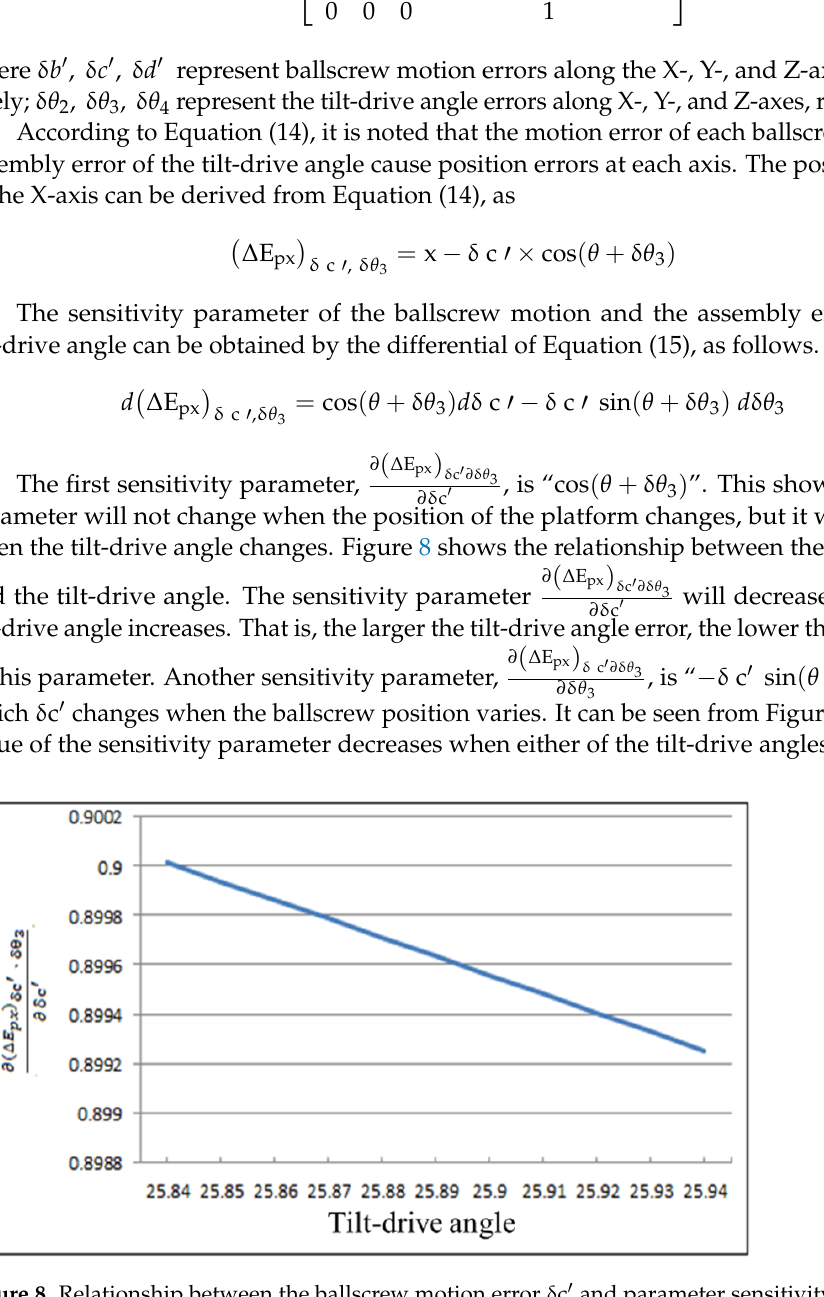
Figure 8. Relationship between the ballscrew motion error δ c ′ and parameter sensitivity.